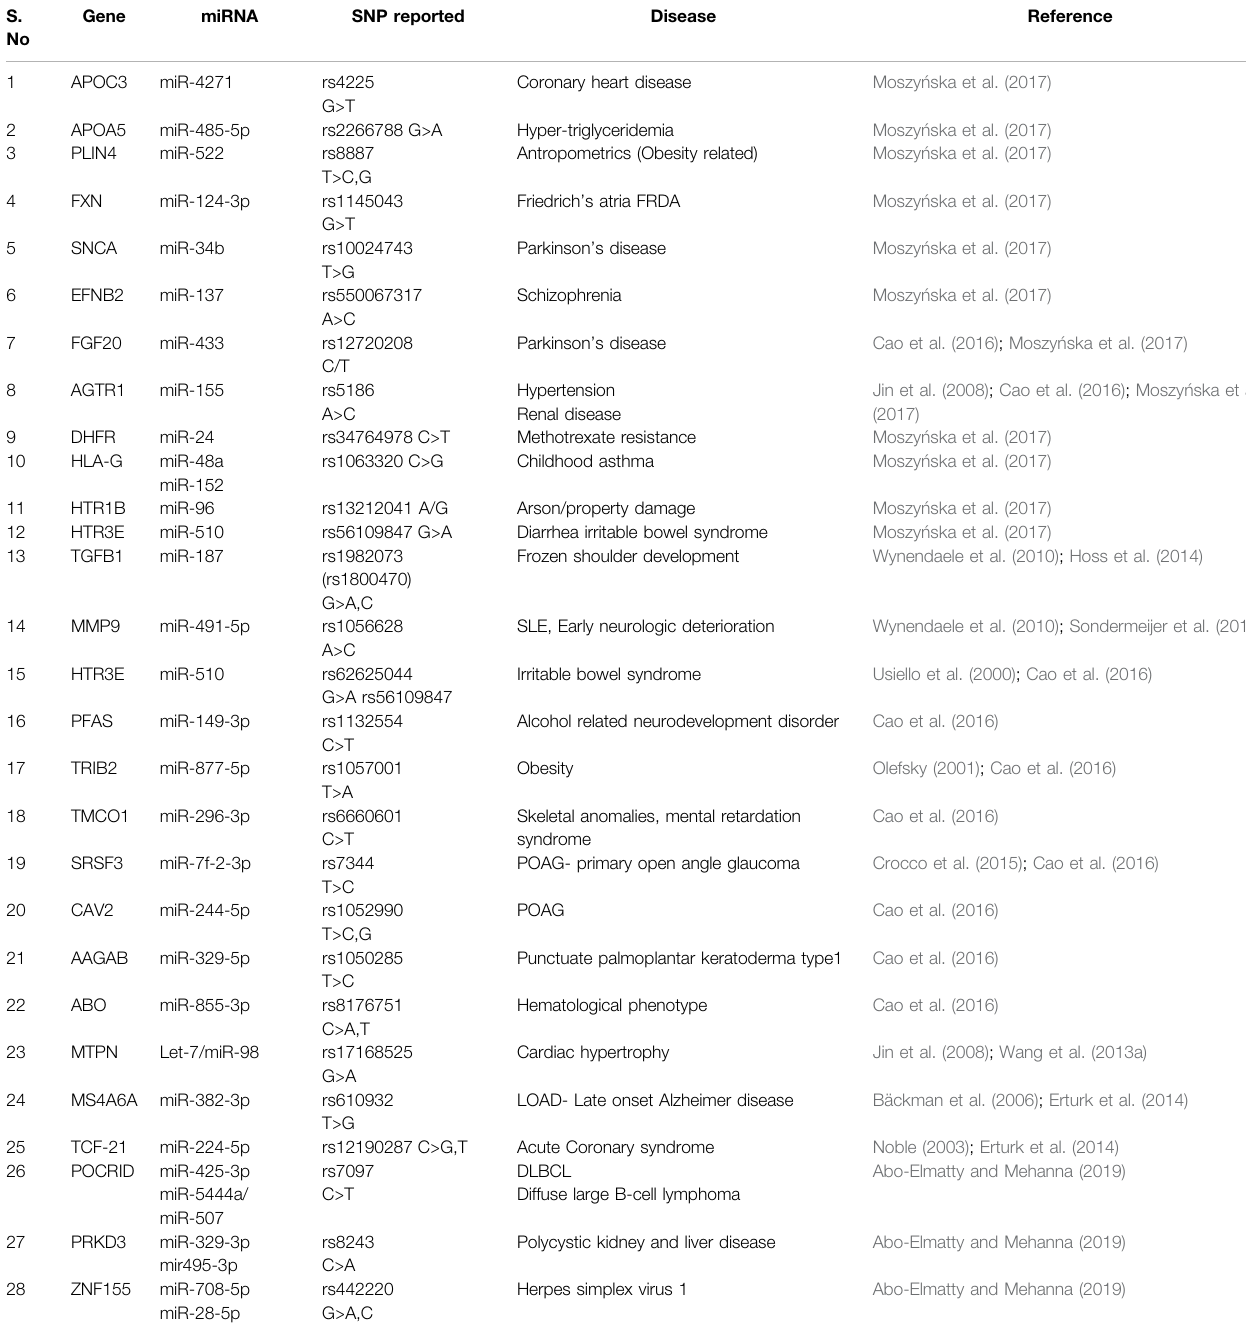
TABLE 6 | SNPs in 3 ′ UTR in target gene of miRNA involved in various